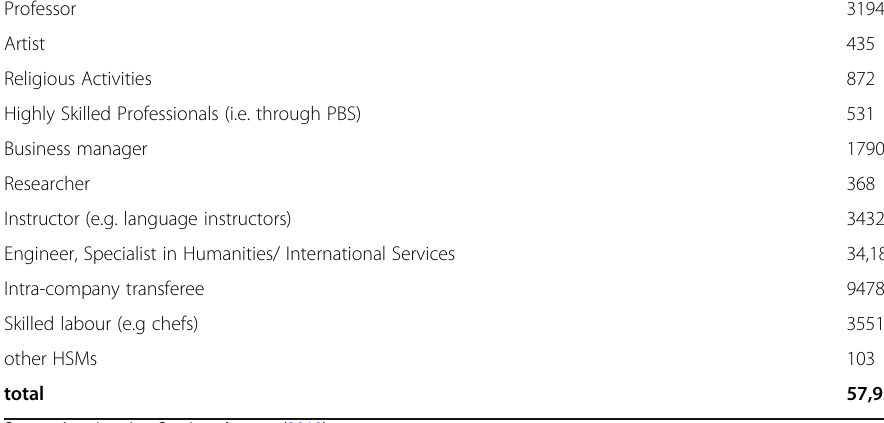
Table 3 newly arrived HSMs in 2018